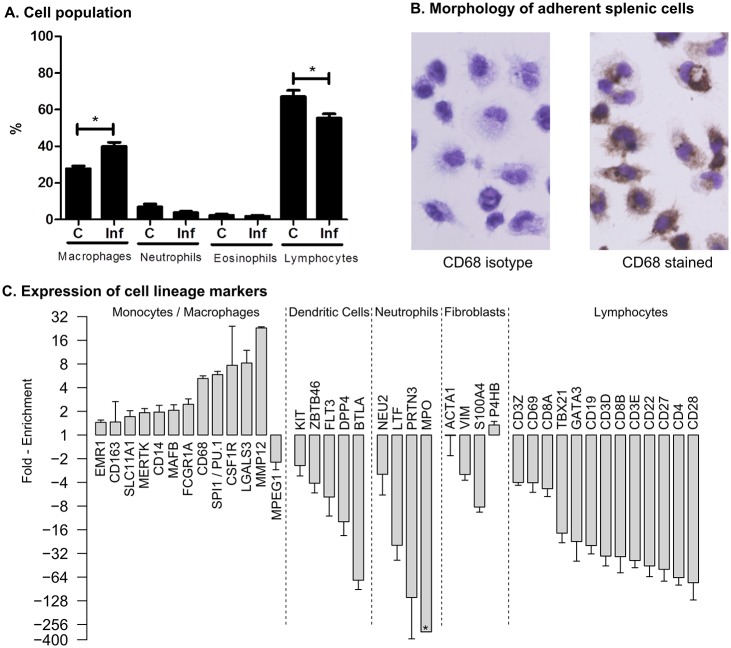
Characterization of a highly enriched macrophage population from the hamster spleen.(A) Percent of macrophages, neutrophils, eosinophils and lymphocytes determined by microscopy of Hematoxylin and Eosin stained cytospin preparations of spleen cells from uninfected control (C) and 28-day L. donovani infected (Inf) hamsters (n = 4 per group). *p<0.05 (B) Immunostaining of the enriched splenic macrophage population for intracellular CD68. An isotype-matched antibody was used as a control, and cells were counterstained with Mayer’s hematoxylline. (C) Expression of specific cell lineage markers in the enriched splenic macrophage population. Data are shown as the fold-enrichment of sequence counts in the splenic macrophages relative to the total spleen tissue.